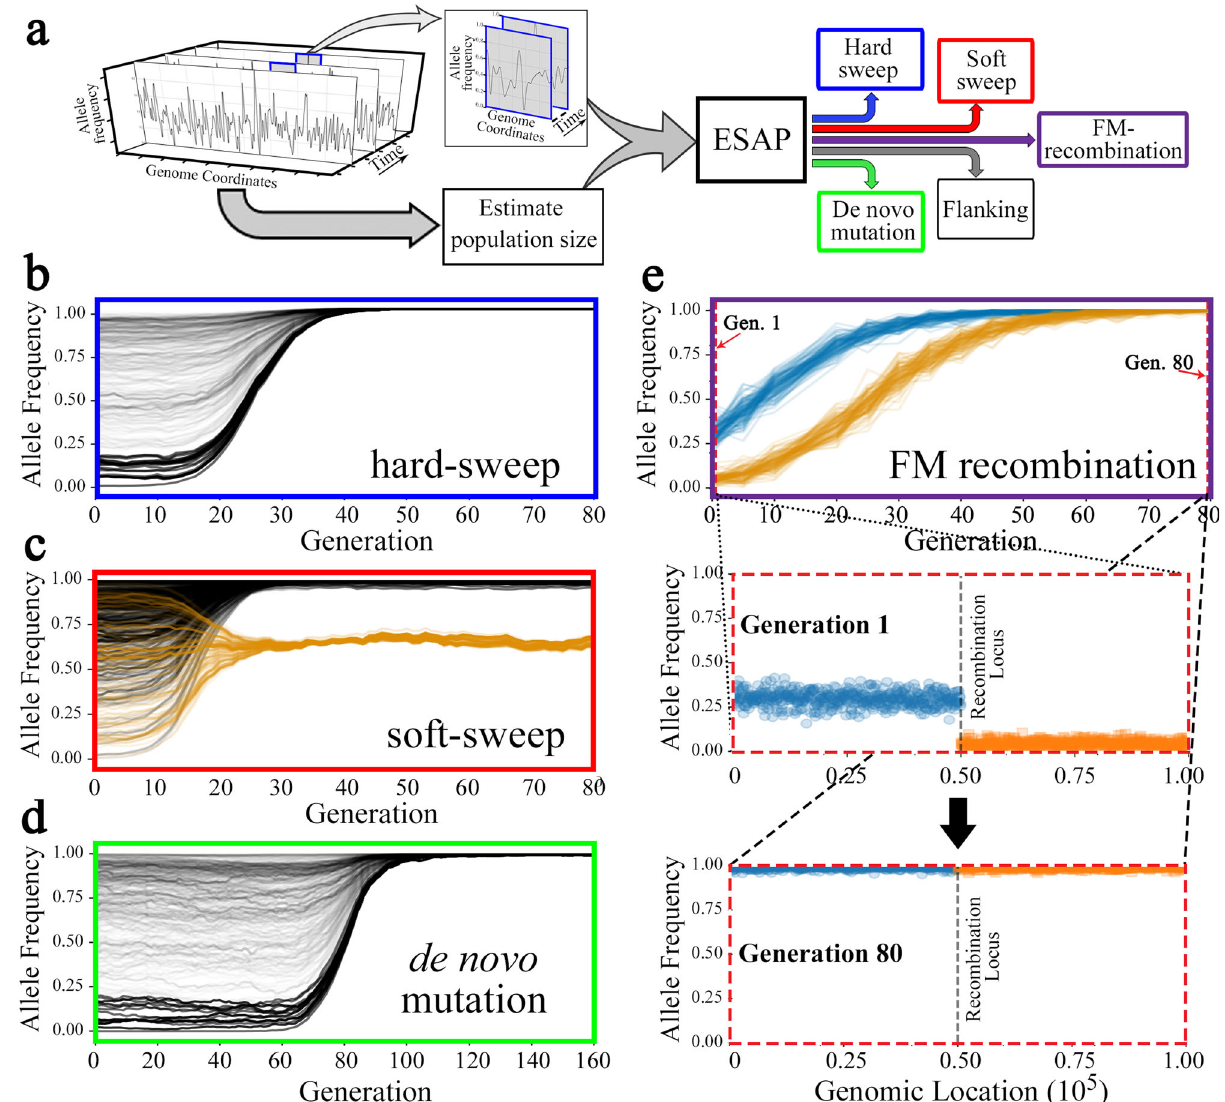
Fig. 2 Deciphering the underlying mechanisms of selection using the Experimental Evolution Selection Analysis Pipeline (ESAP). a ESAP takes a time- series interval of pooled frequencies from a genomic region and predicts the mechanism of the selection sweeps based on allele-frequency trajectories. b The characteristic allele-frequency trajectory for a hard-sweep simulation, when the favored mutation lies on a homogeneous background. The trajectories of all linked mutations on that haplotype converge to fi xation. c The characteristic allele-frequency trajectory in simulations of a soft sweep due to standing variation. The favored mutation itself is fi xed along with tightly linked mutations (black lines). However, the favored mutation is carried by multiple haplotypes, which drift at intermediate frequencies (orange lines). d Simulated instance of favored de novo mutation in a ‘ late ’ sweep. e Simulation of an ‘ FM recombination ’ that combines bene fi cial mutations onto a single haplotype. Starting at generation 80 from a cluster (haplotype) of fi xed alleles, and tracing back in time, ESAP identi fi es two distinct clusters/haplotypes colored blue and orange (top panel). The blue and orange circles in the middle and lower panels provide the allele frequencies and genomic location of the mutations in these haplotypes at generation 1 (middle panel), and generation 80 (lower panel). Note the perfect separation of the two fl anking haplotypes around ChrX:7,750,000 i.e., the recombination